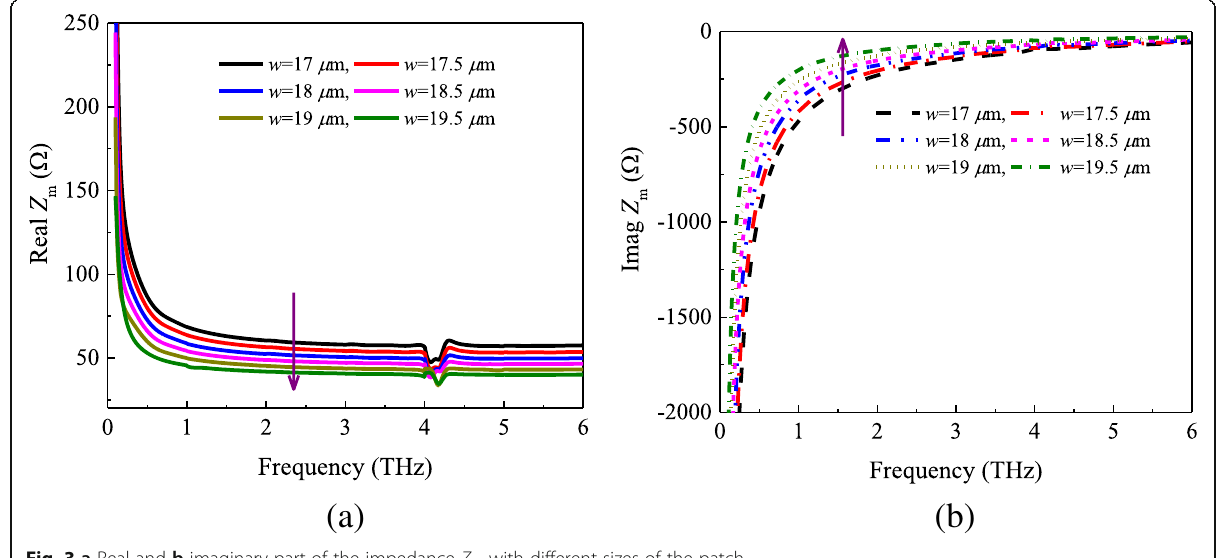
Fig. 3 a Real and b imaginary part of the impedance Z m with different sizes of the patch